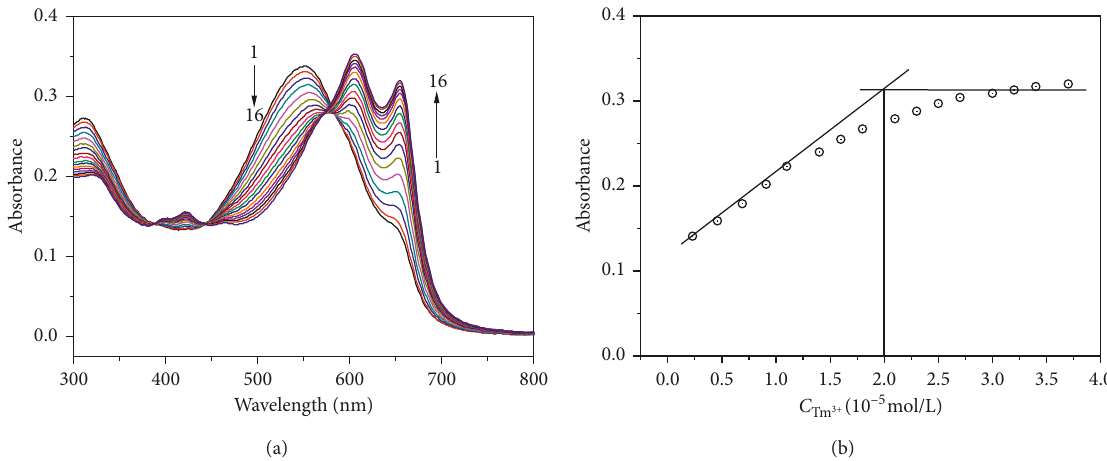
Figure 3: (a) Absorption spectra of ASA in different concentrations of thulium (III); (b) molar ratio of thulium(III)-arsenazo III complex at λ 605nm (pH 7.40). c Arsenazo III (cid:31)